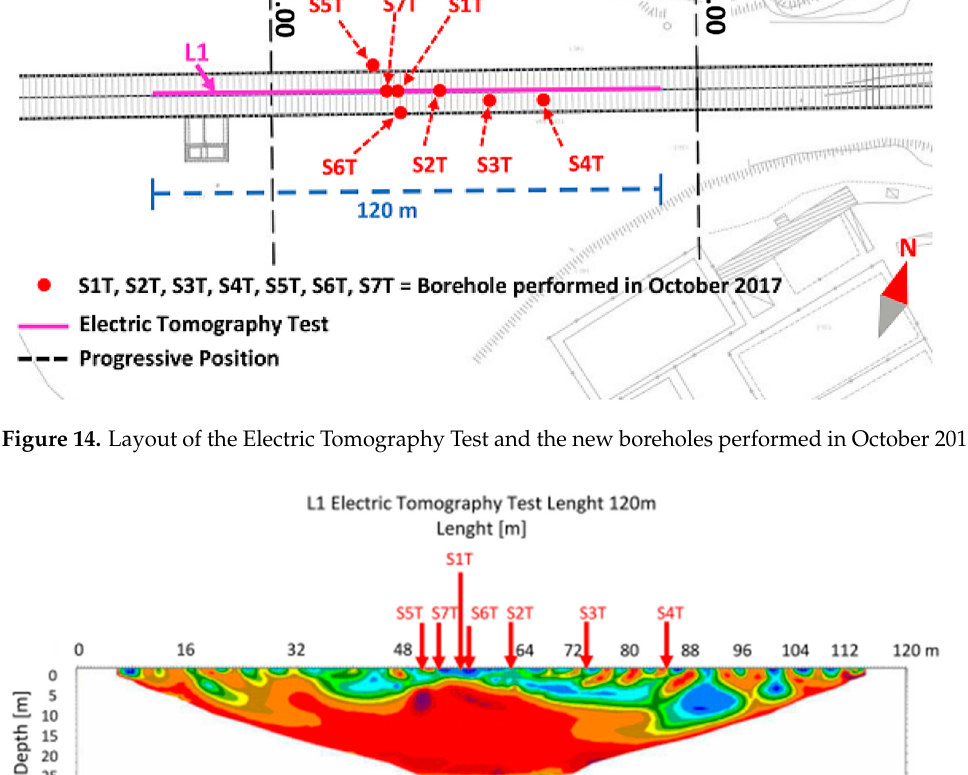
Figure 15. Results of the Electric Tomography Test performed in October 2017.